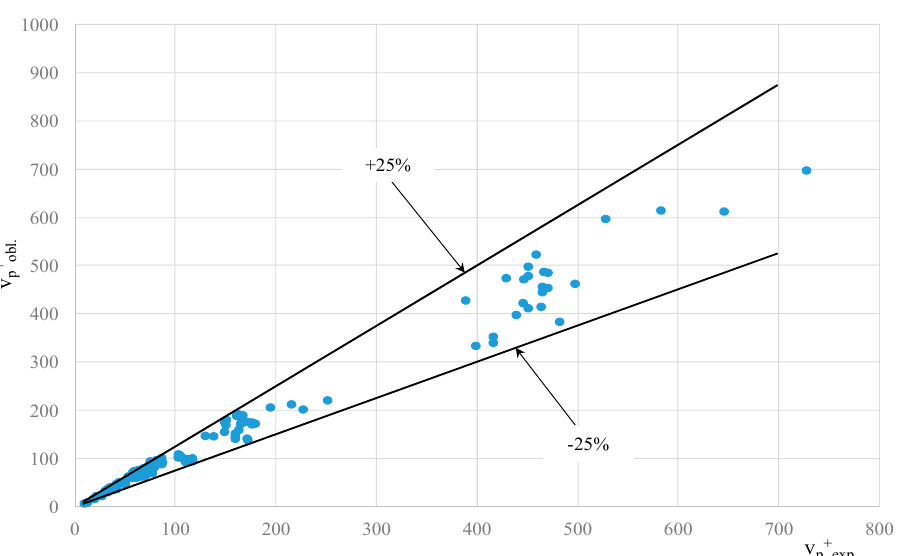
+ v . obtained by dimensional analysis on the regp + v for R1234yf. exp. p